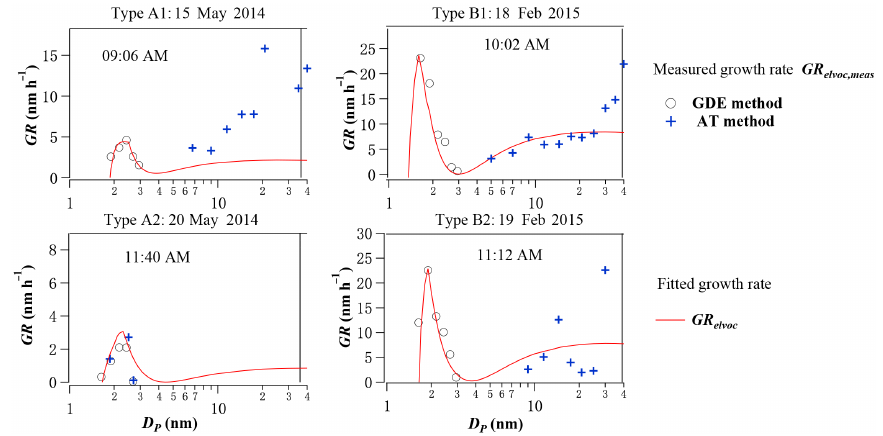
Figure 9. Comparisons of measured (GR elvoc , meas , black circle) and fitted (GR elvoc , red line) growth rates from Eq. (4) for typical Type A1, A2, B1, and B2 events. Also shown were growth rates calculated from appearance-time method (blue cross) for sub-3nm particles when growth rate was relatively small or for larger particles with large size intervals.